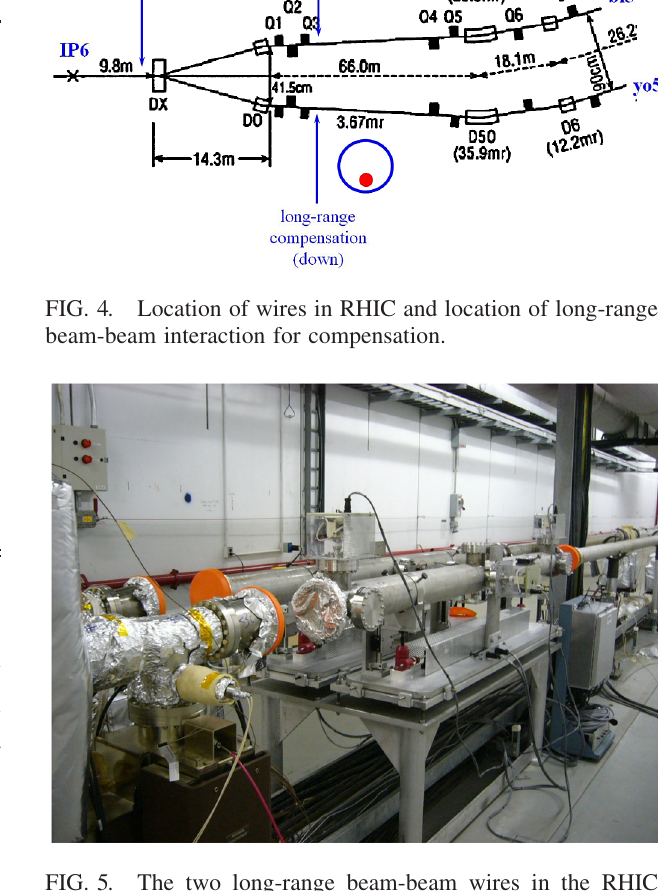
FIG. 5. The two long-range beam-beam wires in the RHIC tunnel